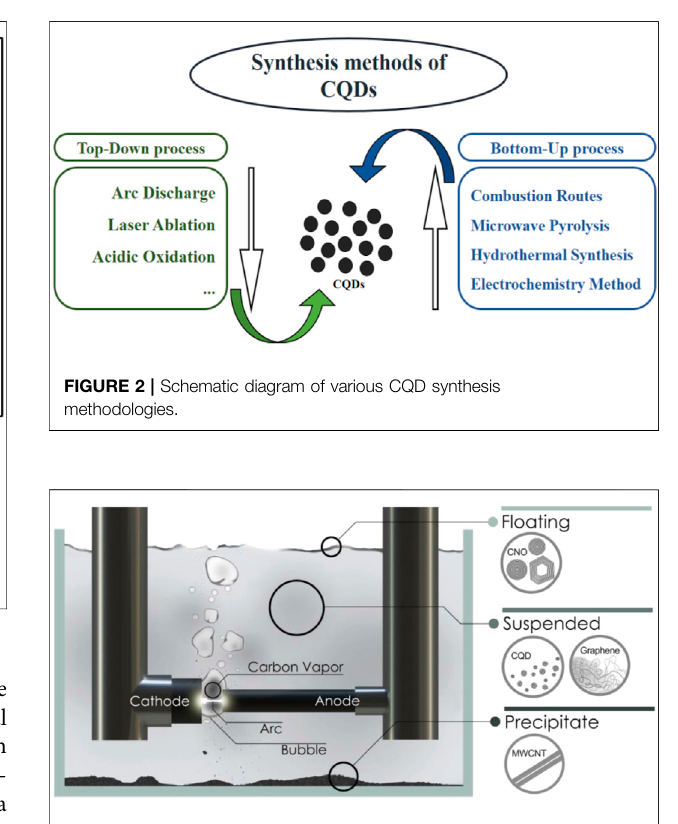
FIGURE 3 | Schematic representation of the submerged arc-discharge in water (SADW) method for production of CQDs. Reprinted with the permission from Chao-Mujica et al.